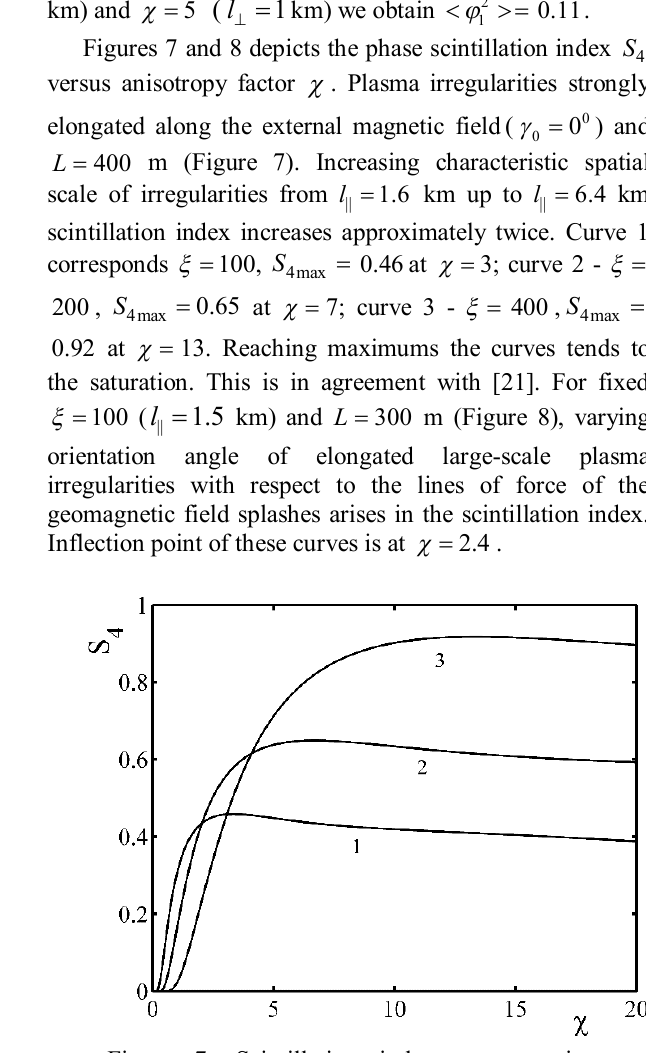
Figure 6: The same as on figure 5 at . Figure 7: Scintillation index versus anisotropy coefficient for different parameter at